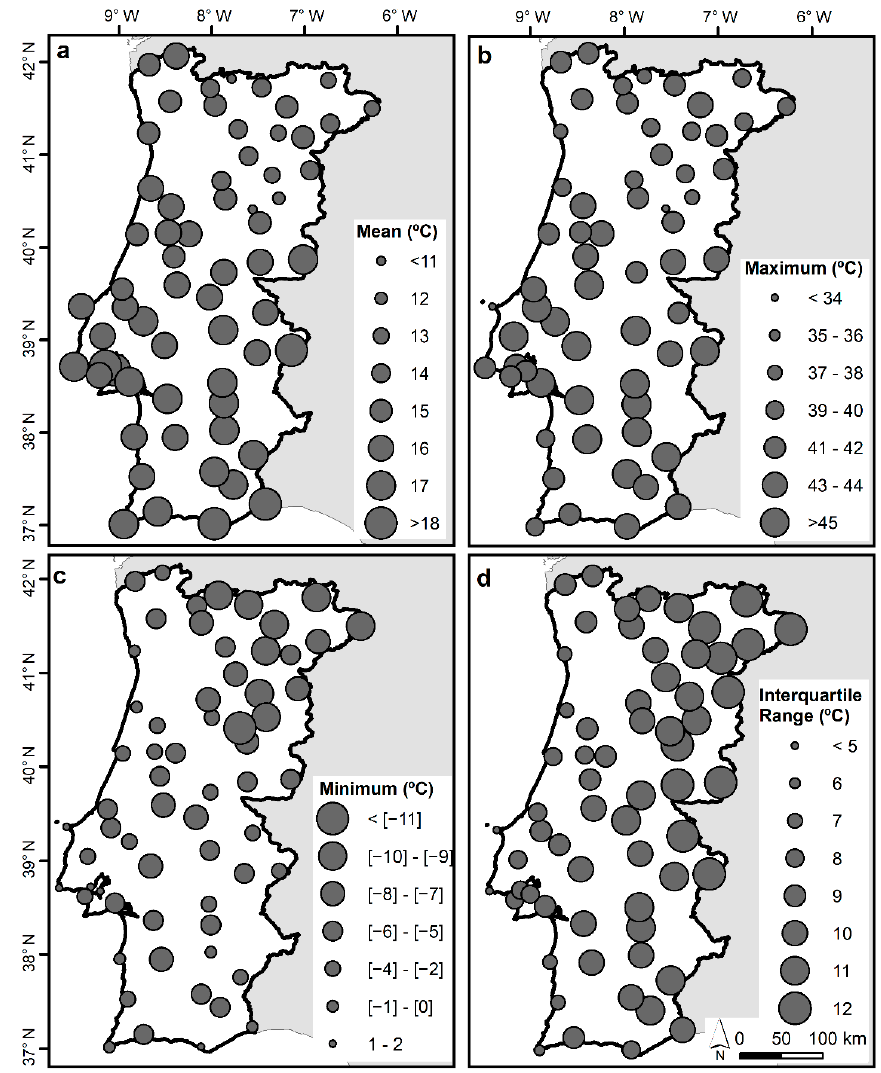
Figure 2. ( a ) Mean temperature, ( b ) maximum temperature, ( c ) minimum temperature, and ( d ) interquartile ranges (75th–25th percentiles) for the period of 2000–2018. The dots are scaled according to the level of magnitude of the temperature.